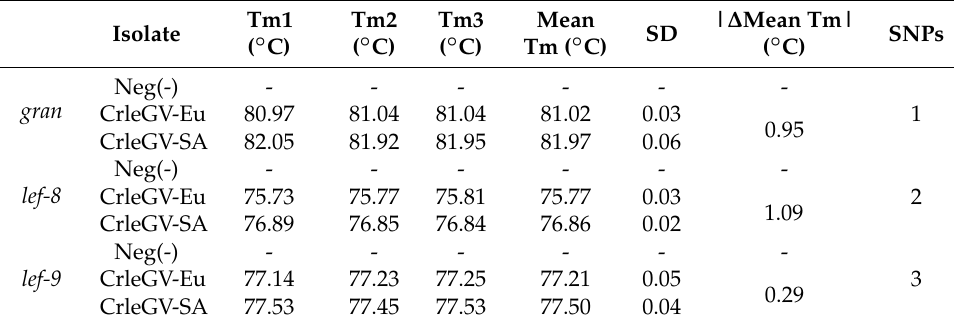
Table 2. Melting temperatures from real-time PCR analysis using universal pairs of primers that allow for amplification of short fragments of gran , lef-8 , and lef-9 on the DNA of CrleGV isolates—European (Eu) and South African (SA). Tm from three repetitions with mean Tm and SD are shown. The negative control (Neg(-)) included alphabaculovirus LdMNPV DNA. The absolute values from the Tm difference between both isolates are shown. SNPs—single nucleotide polymorphism sites.